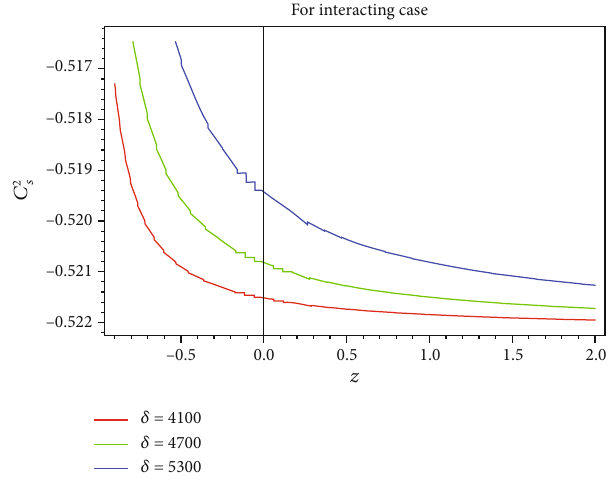
versus redshift s